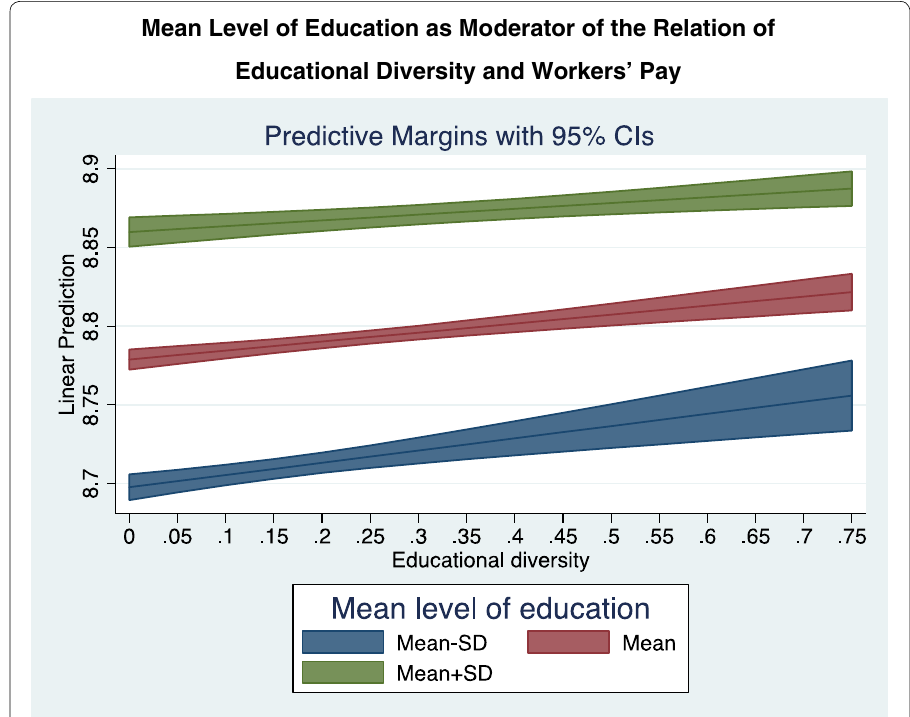
Figure 4 Mean level of education as moderator of the relation of educational diversity and workers’ pay. Source: Authors’ calculations with data from the